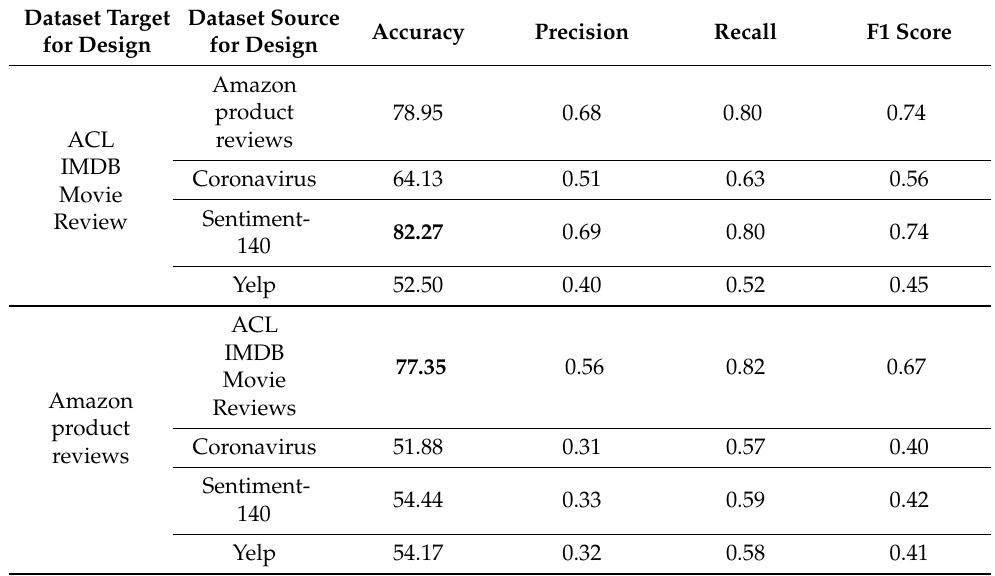
Table 9. Results for reusing pipeline designs created for one sentiment analysis dataset on